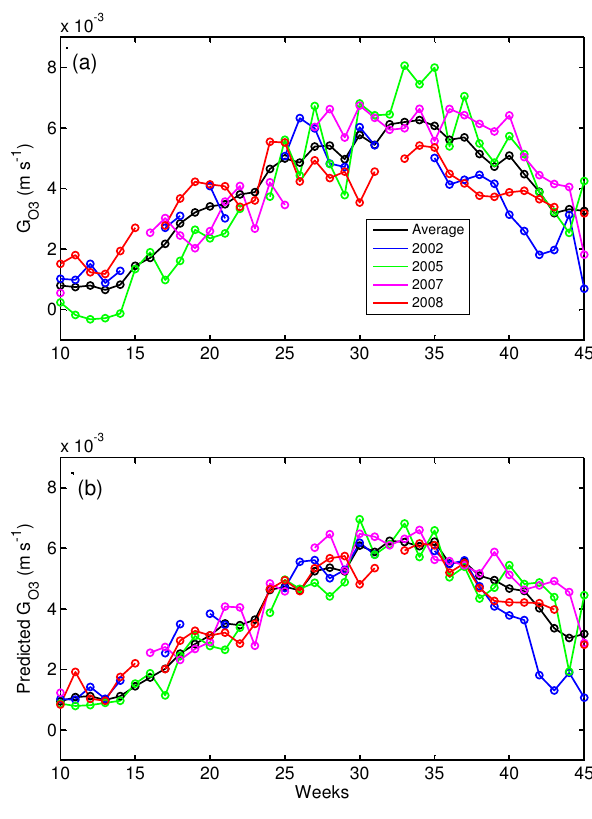
Fig. 8. Weekly average total O 3 conductance for day-time condi- tions (elevation angle of sun >10 ◦ ) as observed (a) and predicted by using the partial least squares technique (b)